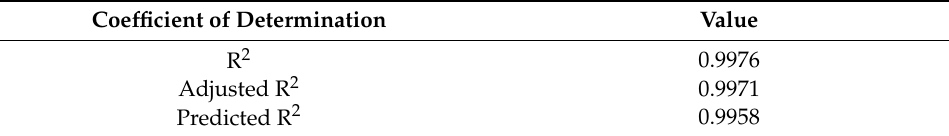
Table 4. Coefficient of determination for